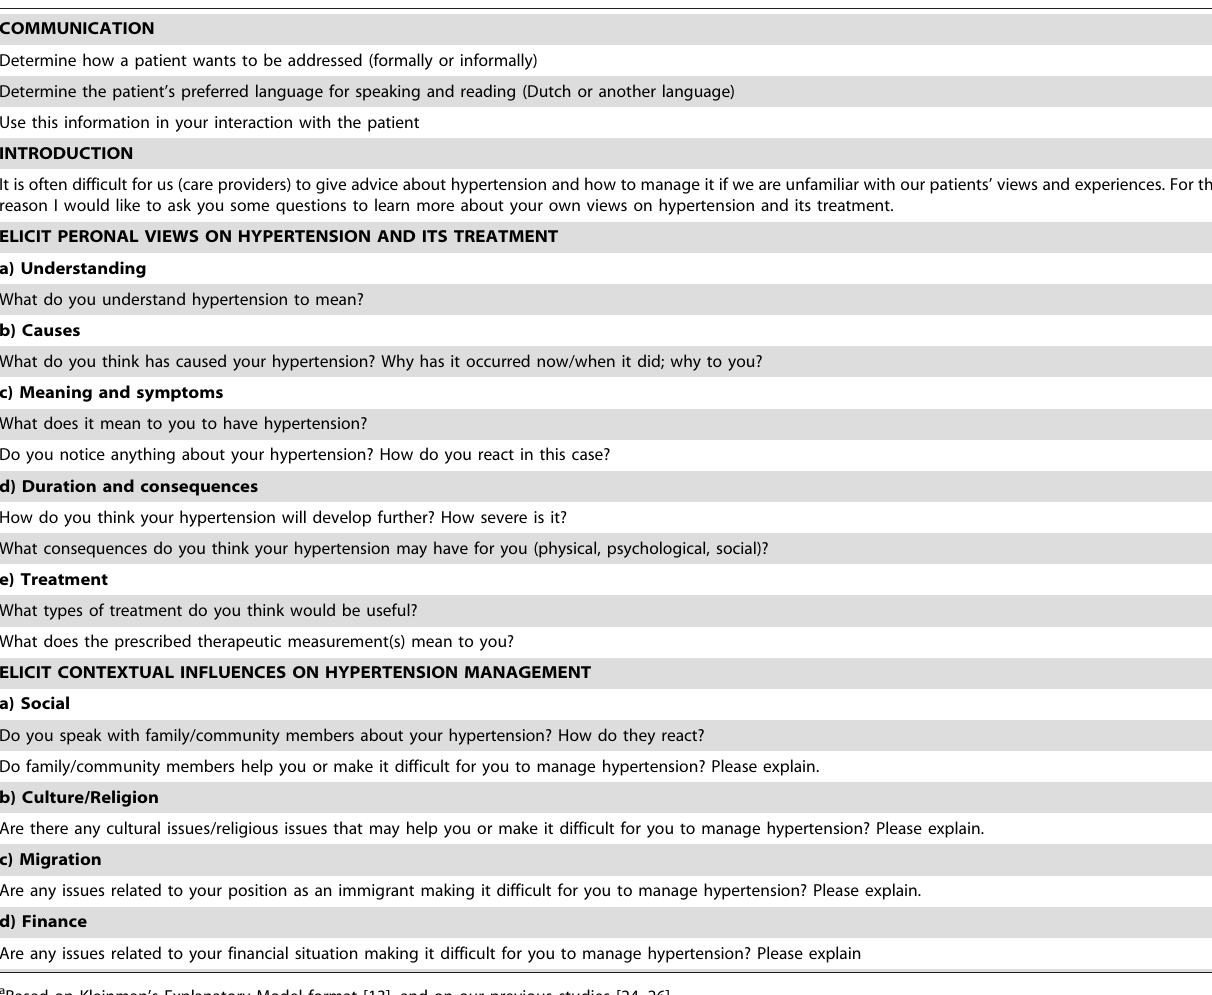
Table 2. Culturally-sensitive framework for eliciting a patient’s explanatory model of hypertension a .